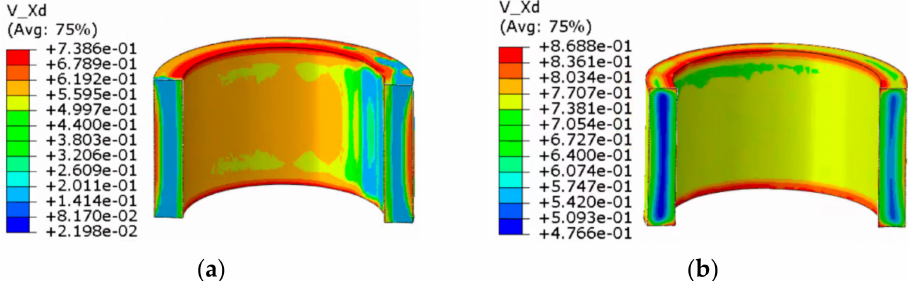
Figure 9. Nephogram of dynamic recrystallization volume fraction distribution without considering the shear effect: ( a ) first pass rolling; ( b ) second pass rolling.